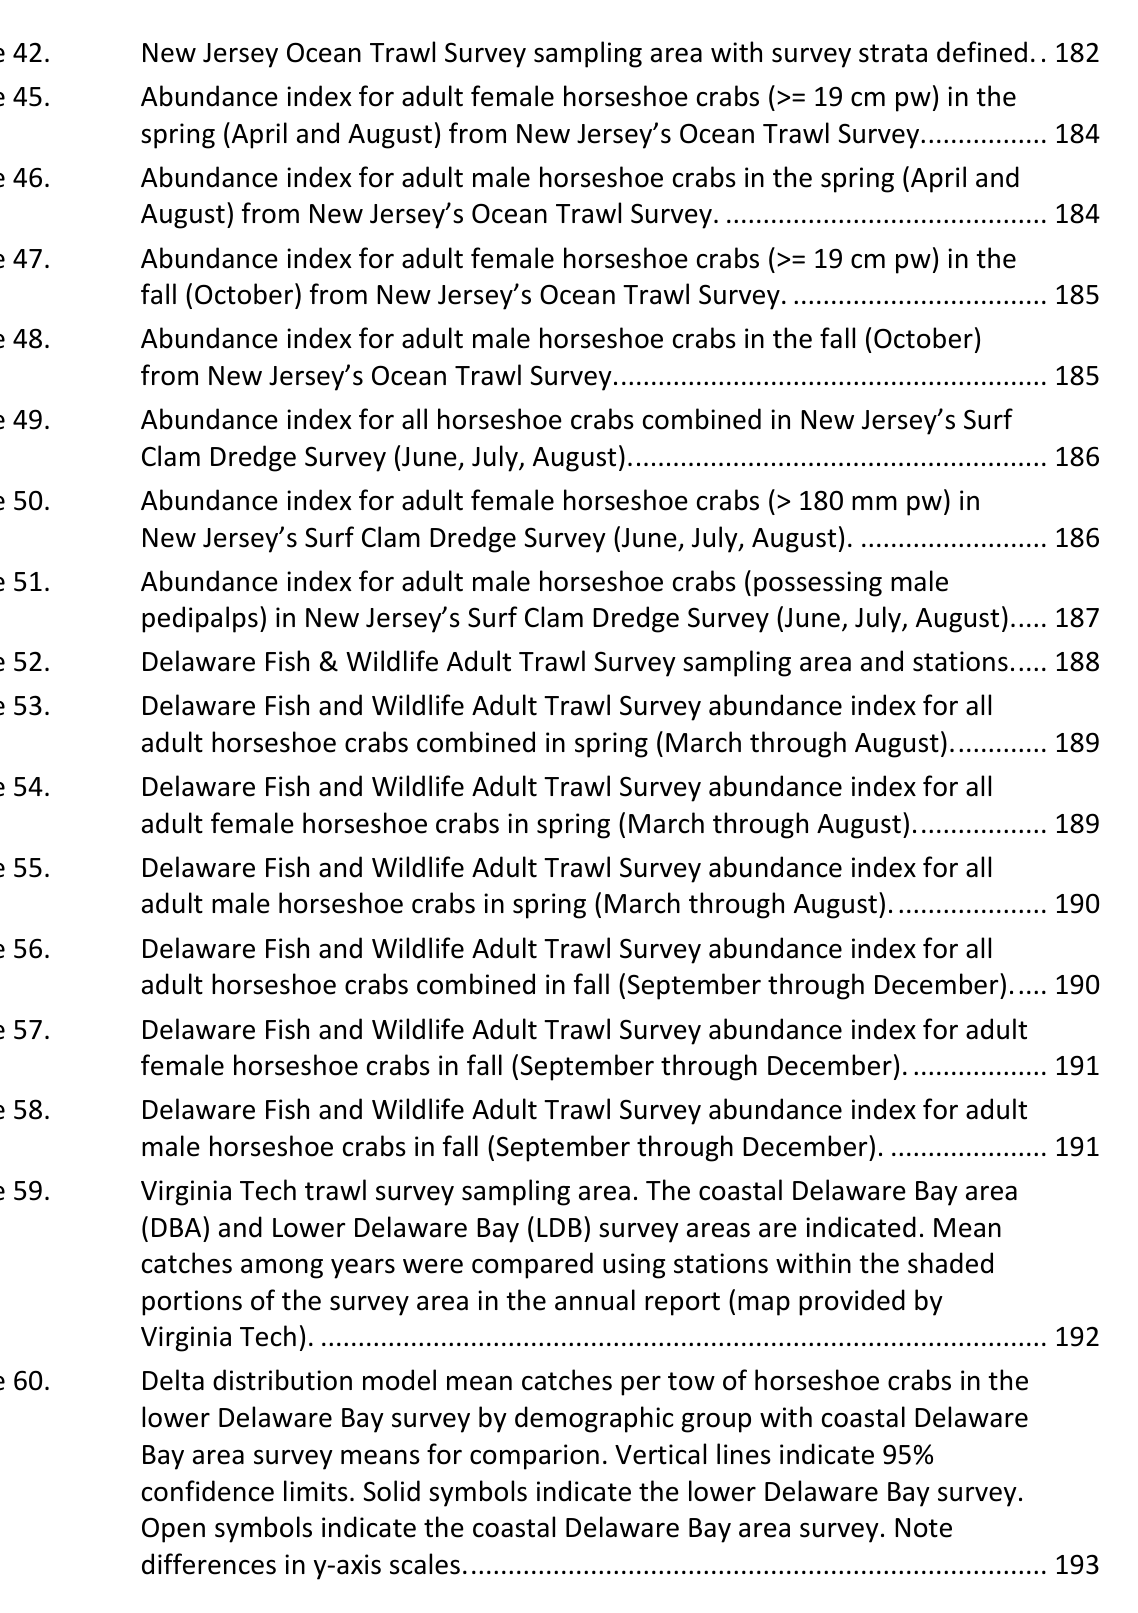
Virginia Tech trawl survey sampling area. The coastal Delaware Bay area (DBA) and Lower Delaware Bay (LDB) survey areas are indicated. Mean catches among years were compared using stations within the shaded portions of the survey area in the annual report (map provided by Figure 60. Delta distribution model mean catches per tow of horseshoe crabs in the lower Delaware Bay survey by demographic group with coastal Delaware Bay area survey means for comparion. Vertical lines indicate 95% confidence limits. Solid symbols indicate the lower Delaware Bay survey. Open symbols indicate the coastal Delaware Bay area survey.